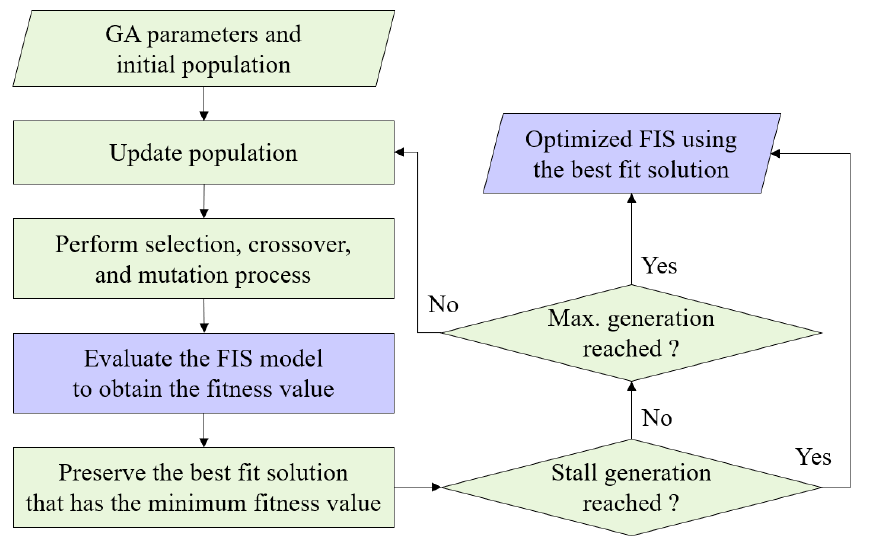
Figure 4. Flowchart for the training